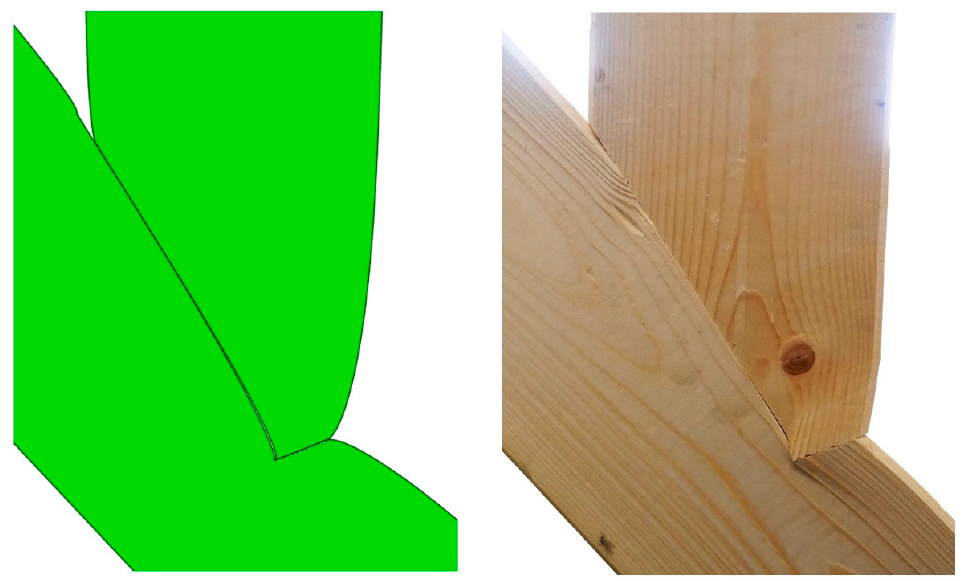
Figure 17. ( Left ): Deformation of numerical model; ( Right ): failure of single-step joint in the exper- iment.